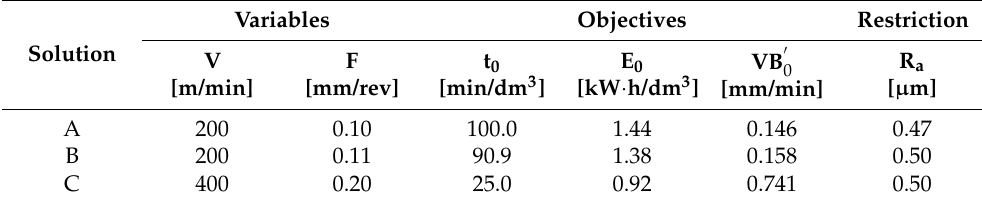
Table 4. Relevant solutions for dry machining.